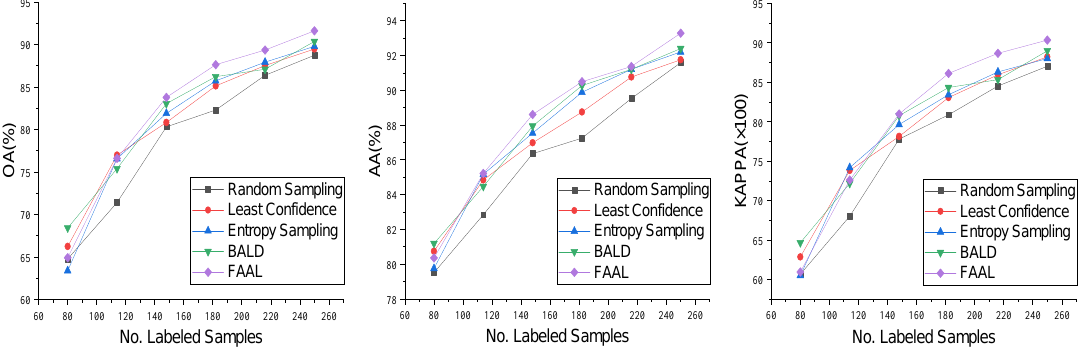
Figure 6. Performance after each active learning loop on Indian Pines. The number of initial labeled samples is 80. There are 114, 148, 182, 216, and 250 labeled samples after the first, the second, the third, the fourth, and the fifth active learning loop, respectively. Three general metrics: OA (leftmost), AA (middle), and KAPPA (rightmost) are used for comparison.